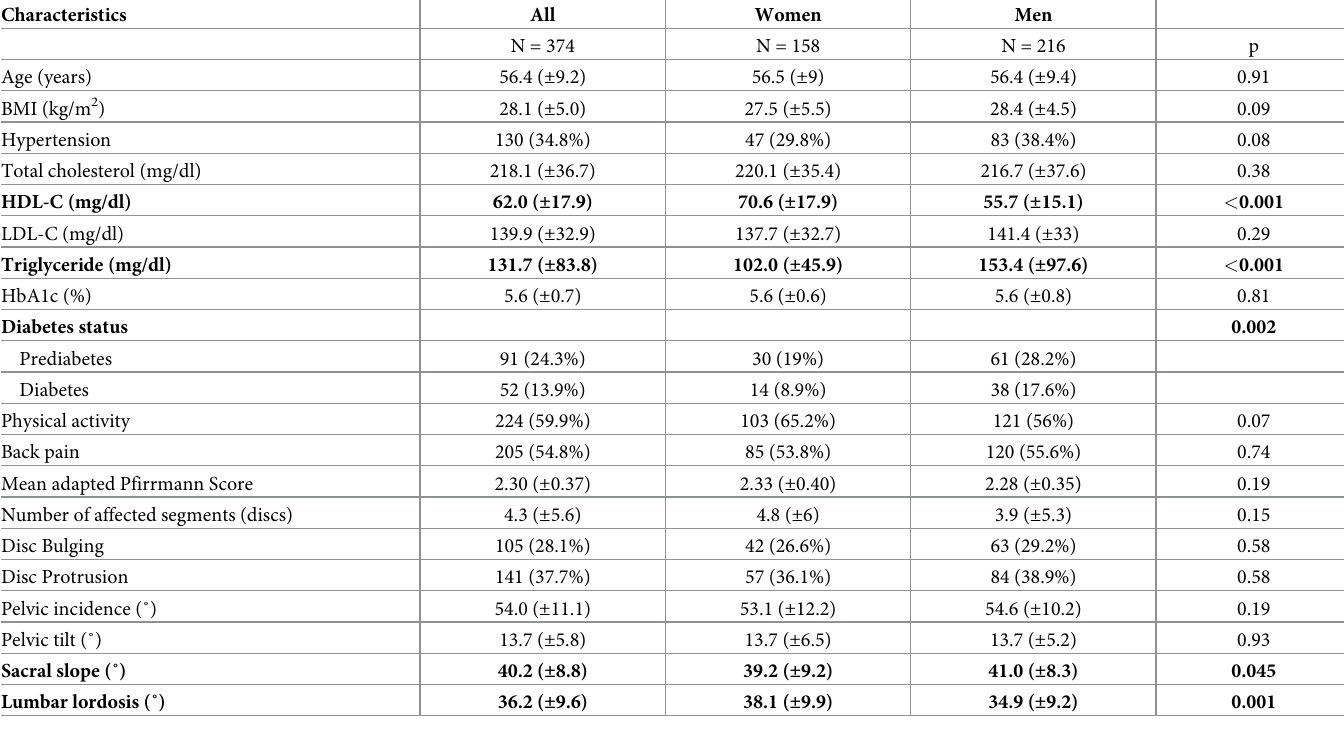
Table 2. Descriptive demographic, spinopelvic and disc degeneration parameters of the study sample and according to gender. Characteristics